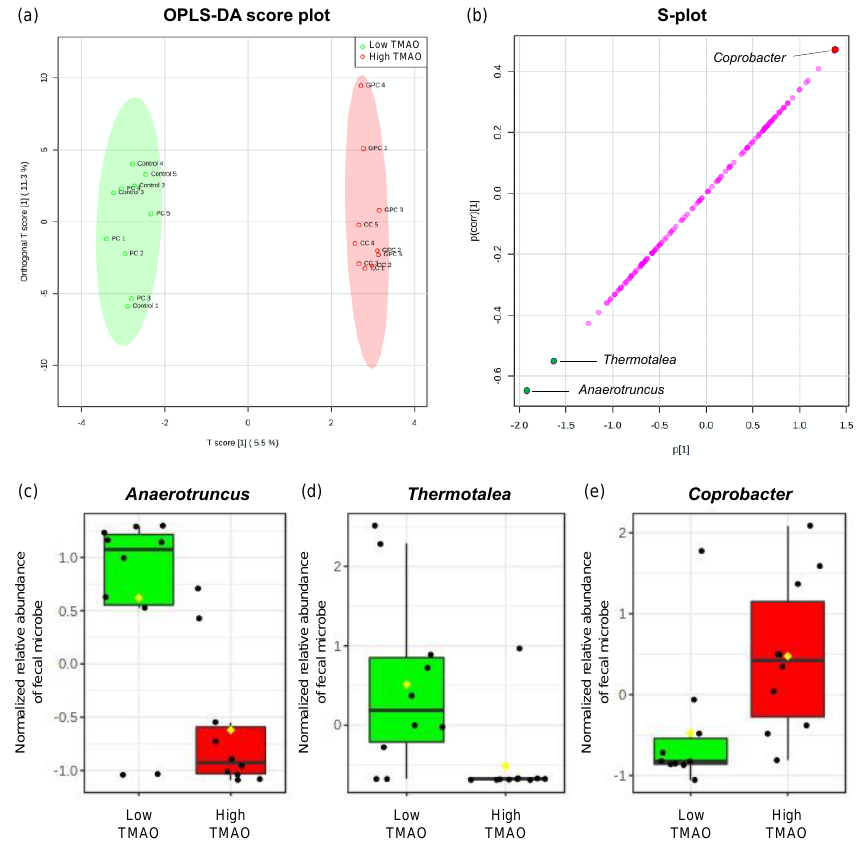
Figure 7. OPLS-SA of low and high TMAO groups, based on fecal microbiota at the genus level. ( a ) OPLS-DA score plot, ( b ) its corresponding S-plot, and ( c – e ) characteristic gut microbes that can discriminate between the low and high TMAO groups (normalized data are represented as box plots with each and mean values as shown black and yellow squares, respectively). Variables with a variable importance of projection (VIP) of >2.0 are highlighted with green or red filled circles.